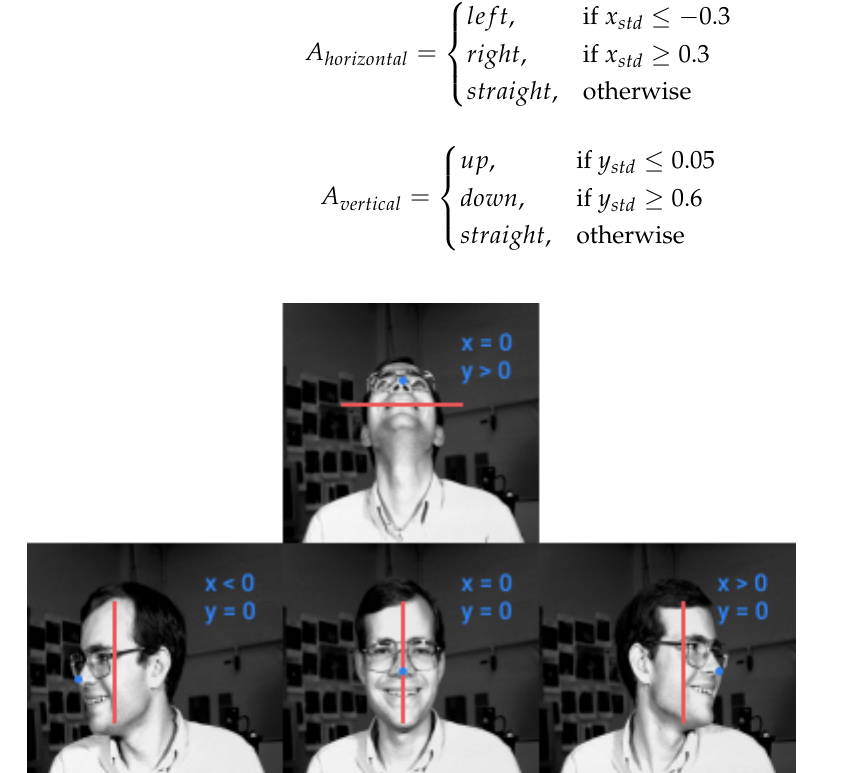
Figure 3. Face orientation and the nose